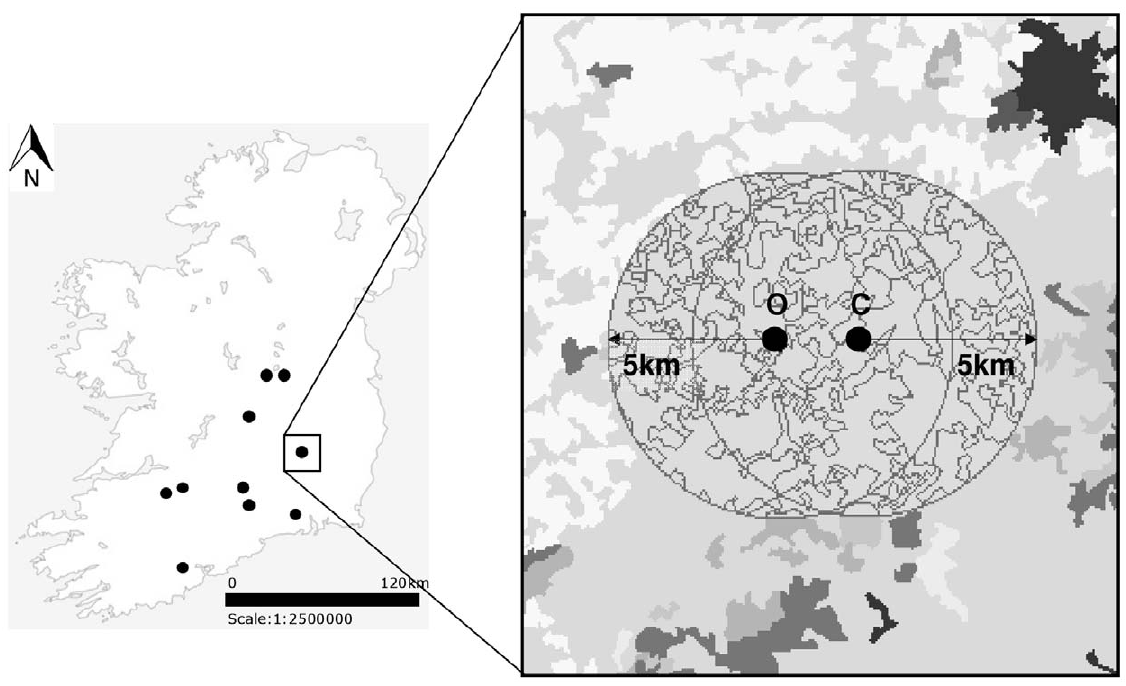
Figure 1. The distribution of the ten farm pairs within Ireland. For each farm, the percentage of different land-use types within 1, 2, 3, 4 and 5 km radii around farms was determined (the extent of the 5 km radii is shown as an example in this figure). Landscapes were similar and overlapping within a farm pair only. Note: CORINE Level 4 classification is displayed within the circular sectors while CORINE Level 3 classification is displayed outside them. O = organic farm, C = conventional farm.